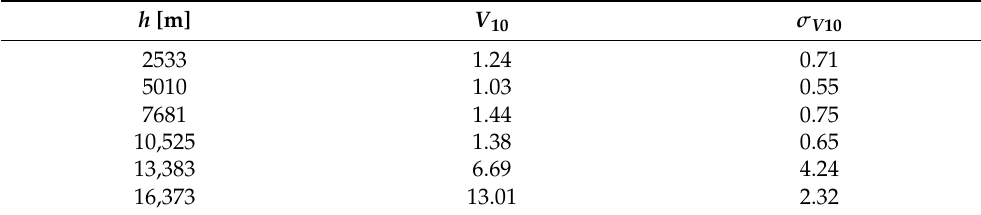
Table 4. 10-min. average horizontal wind speed, V 10 , and standard deviation, σ V 10 . These values were calculated in the 10-min. lapse before the corresponding